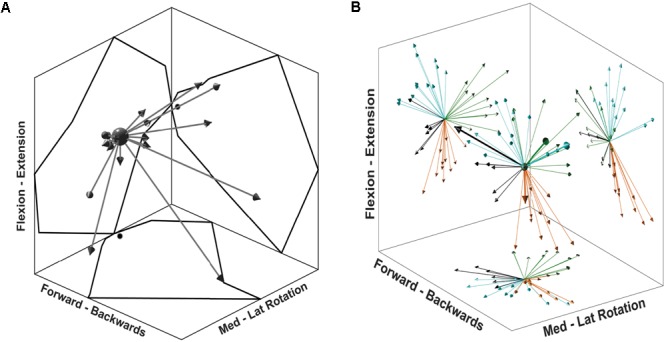
Synergy directional tuning and preferred directions. (A) A single synergy tuning over 26 directions of the multidirectional task. Each arrow represents a single target direction, and the length of the arrows is scaled to the synergy activation coefficient. The outline reflected on the graph walls displays the outer reach of the arrows, black dots on walls indicate the (0,0) coordinate. (B) 3D display of synergy PD for each synergy of all participants. Graph walls display a 2D projection of synergy directions showing the cluster distribution. Each colour represents a cluster identified from the first cluster analysis. Thicker arrows on the 3D display identify the synergies from a single, randomly chosen participant.